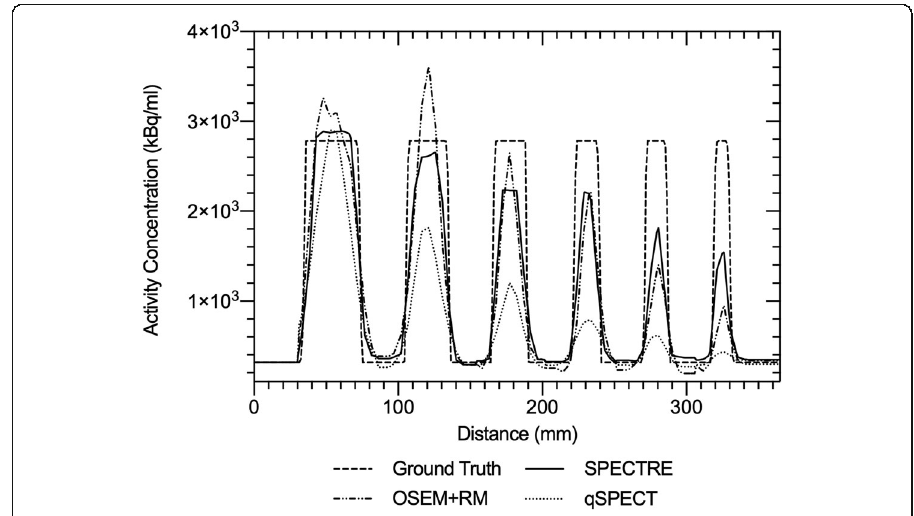
31.5% and 26.9% for the PET, qSPECT, OSEM + RM and SPECTRE reconstructions, respectively.